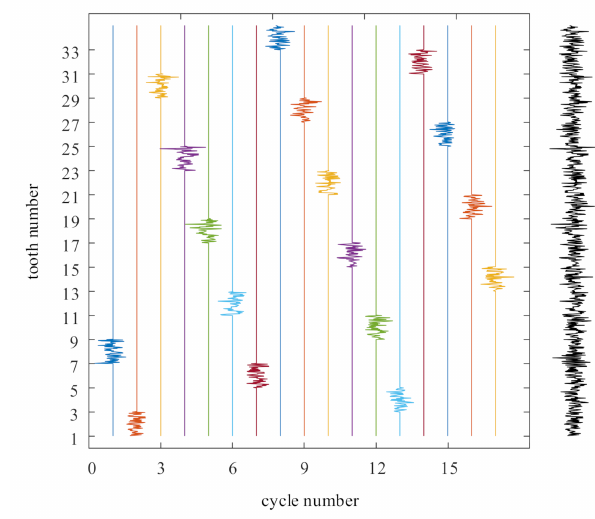
Figure 12. An example of Assembly Holding Matrix